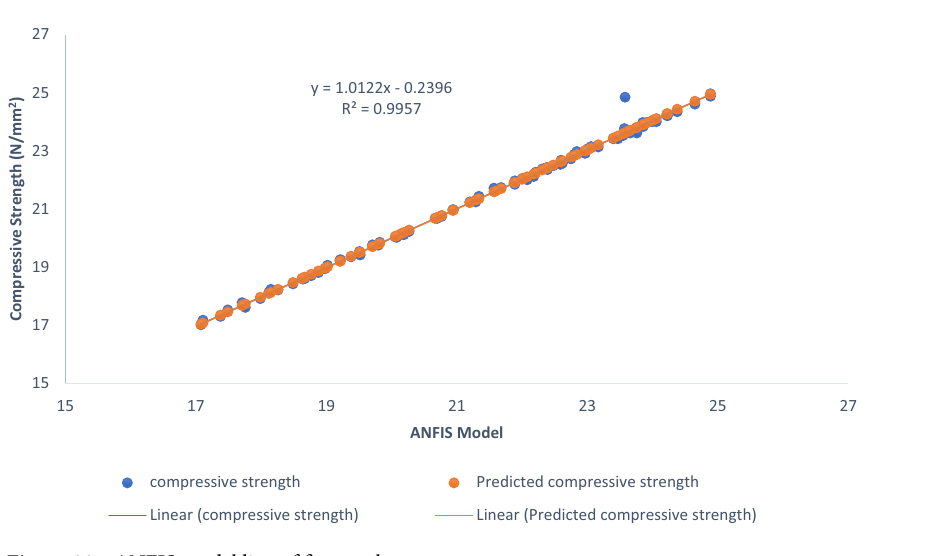
Figure 23. ANFIS model line of fitness